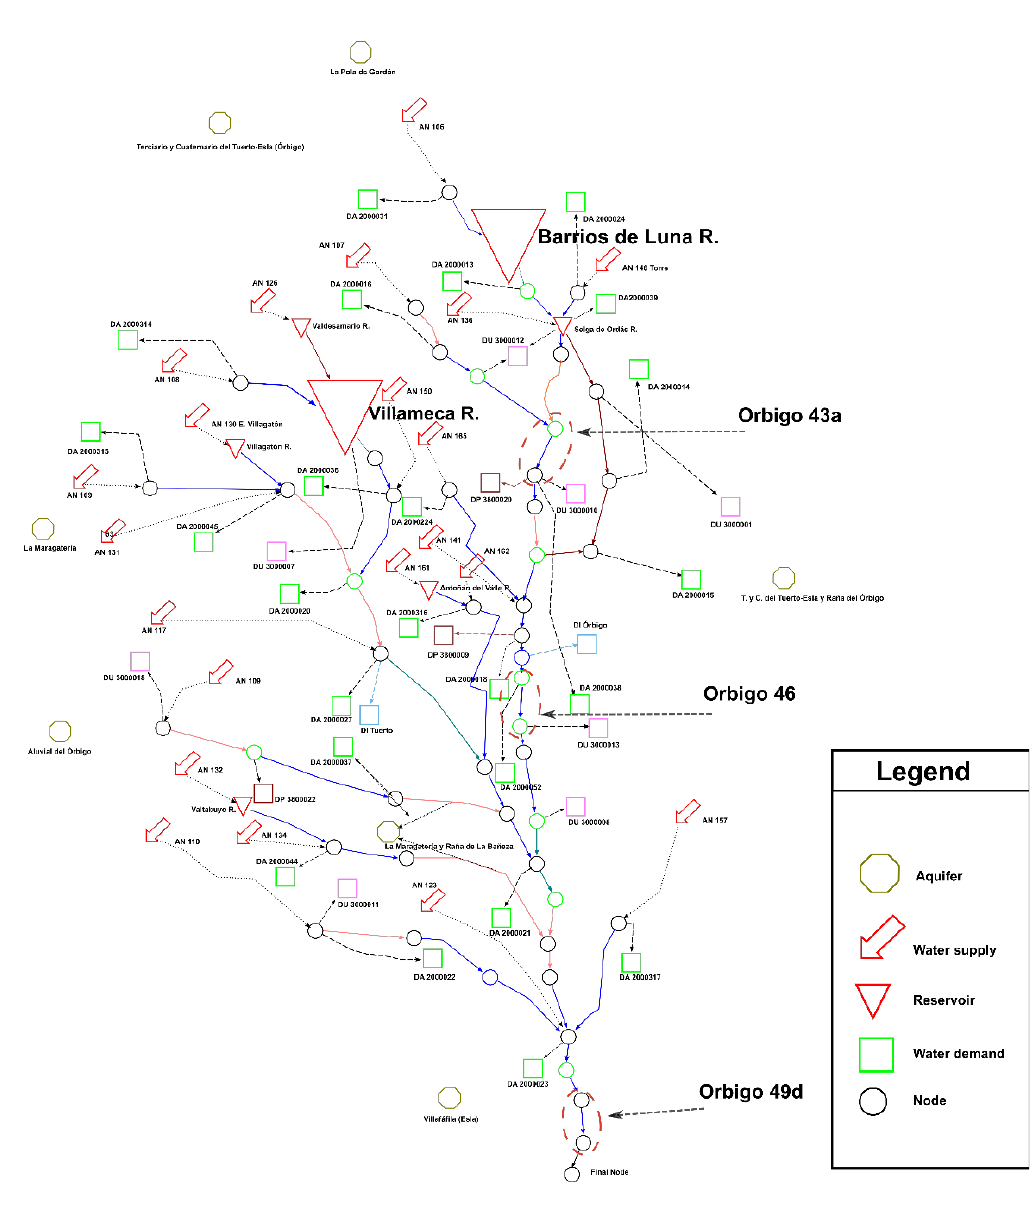
Figure 3. Topology of the Ó rbigo water resources system used in the basin simulation model (SIMGES). The green, pink and blue squares represent agricultural, urban and industrial demand units, respectively. Three river stretches (represented as arrows in the figure) analyzed in this work ( Ó rbigo 43a, Ó rbigo 46 and Ó rbigo 49d) are marked in the